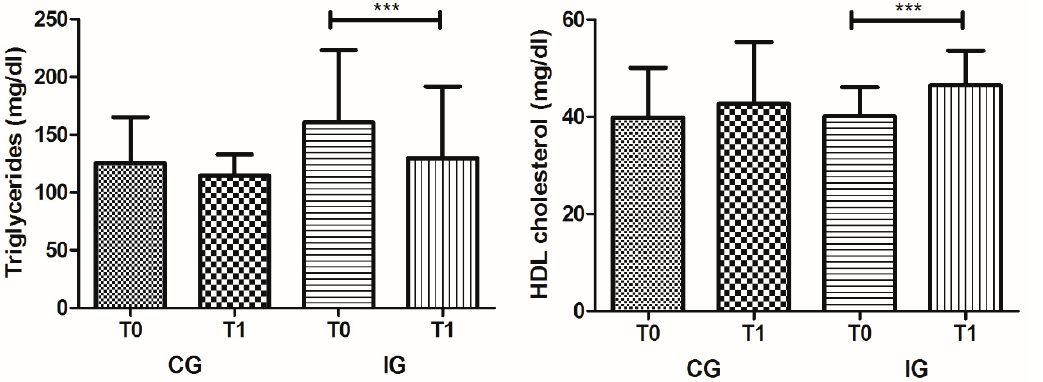
Figure 2. HDL cholesterol and triglycerides serum levels in CG and IG at T0 and T1 moments (*** p < 0.001).